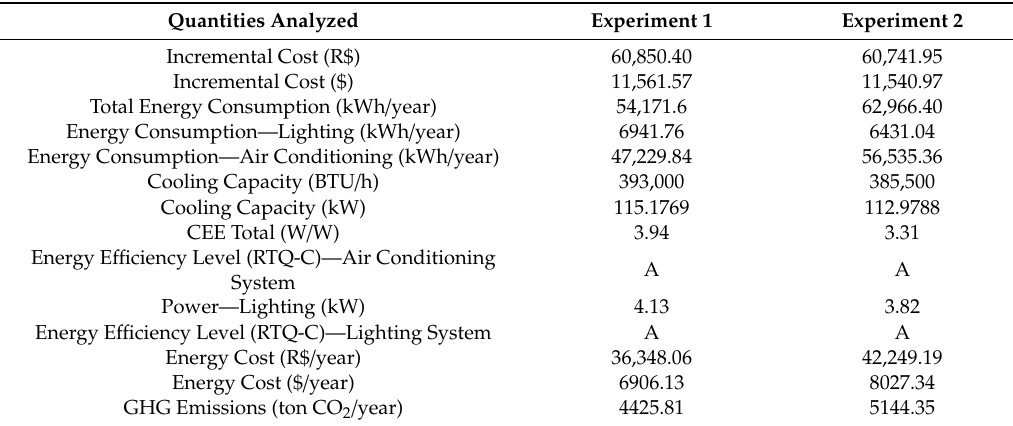
Table 8. Summary of the best fitness individual from Case 2 to Experiment 1 and 2—No